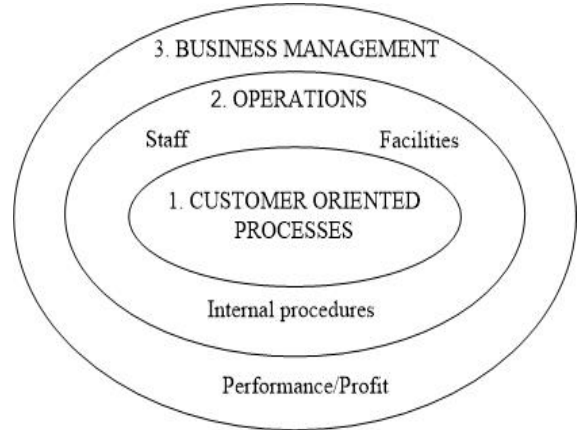
Figure 2. Circles of activities in Toyota